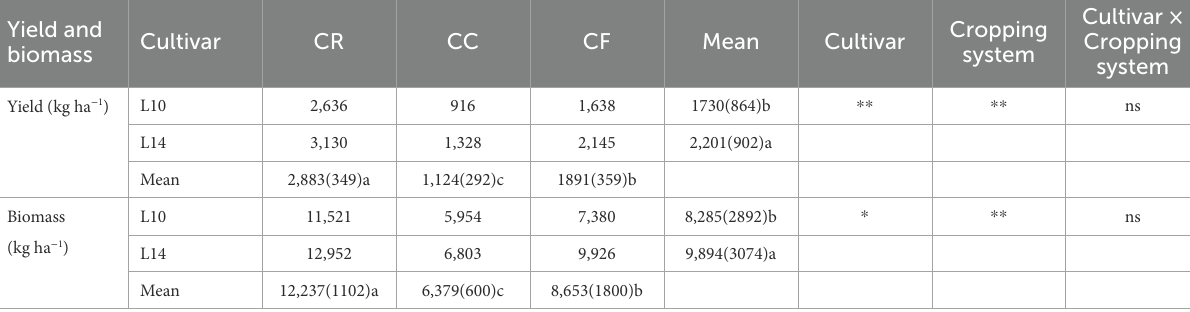
TABLE 1 Effects of crop rotation and continuous cropping on soybean productivity. Yield and Cultivar biomass